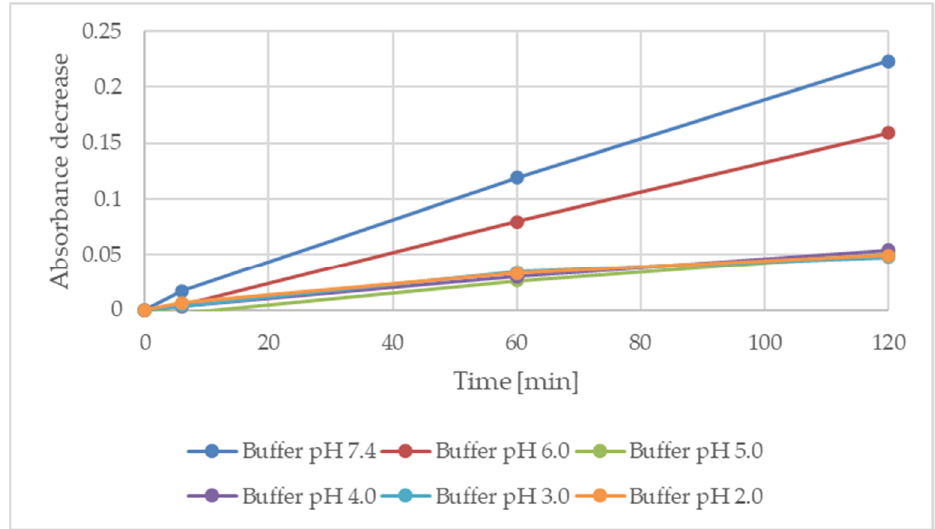
Figure 2. Self-decay of ABTS • in buffers (100 mM) of various pH.